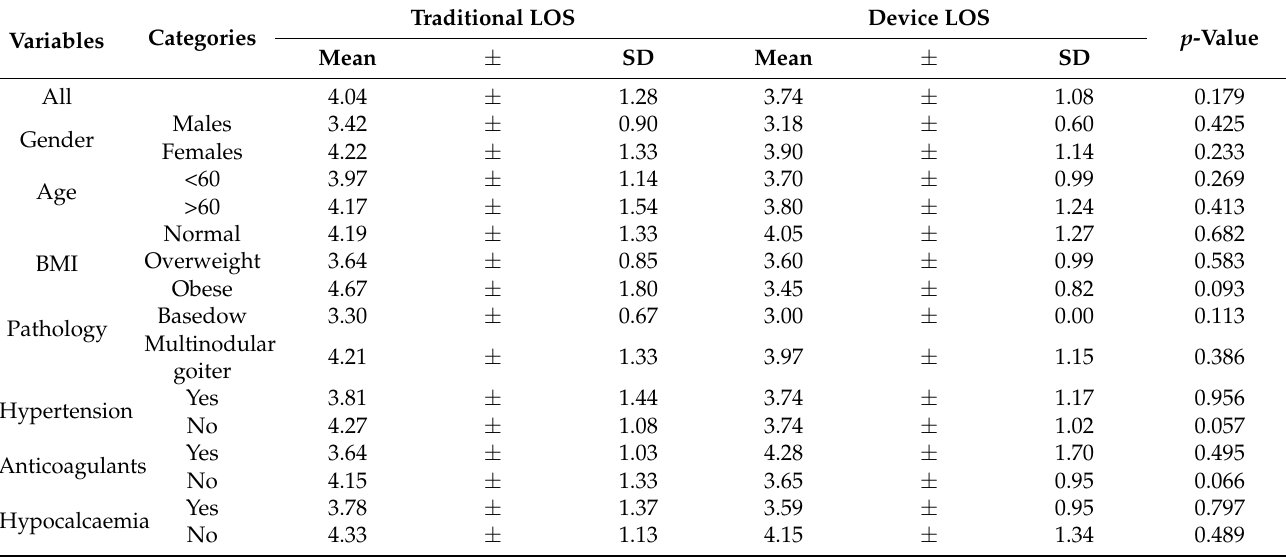
Table 8. Comparison between “Traditional” and “device” groups according to LOS. Abbreviation: BMI: Body Mass Index.